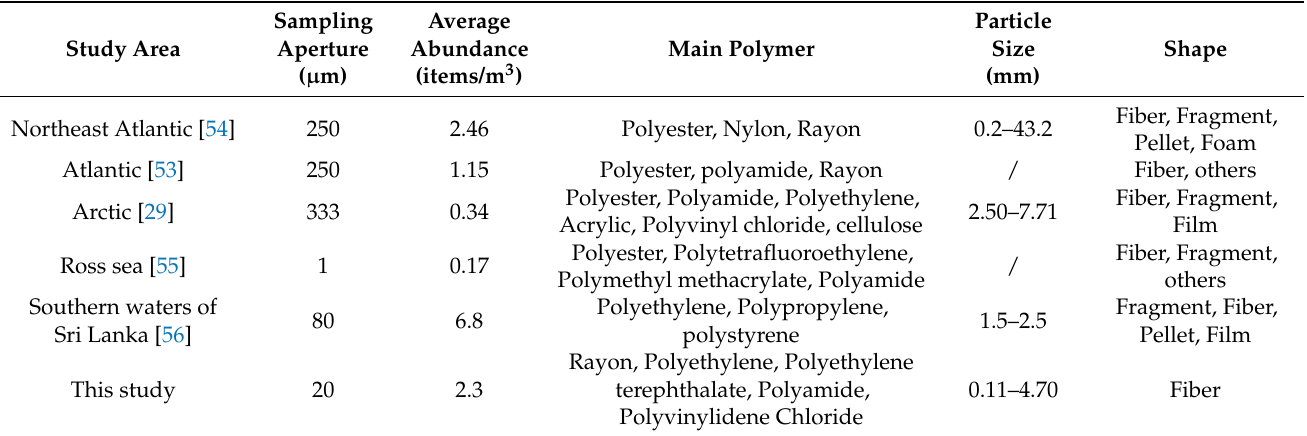
Table 1. Abundance of microplastics in different sea